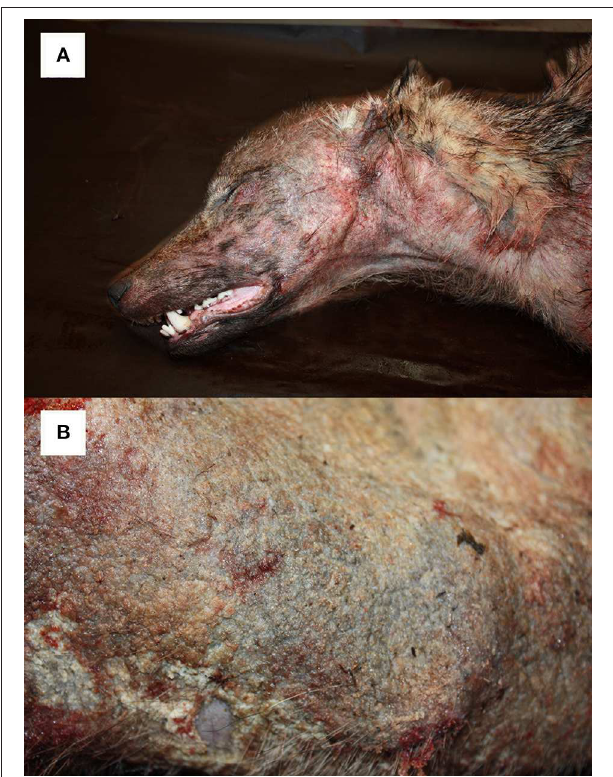
FIGURE 6 | Alopecic form of sarcoptic mange affecting a young (1–2 years) female wolf ( Canis lupus ) from NE Italy. Particularly of the head (A) and the trunk (B)